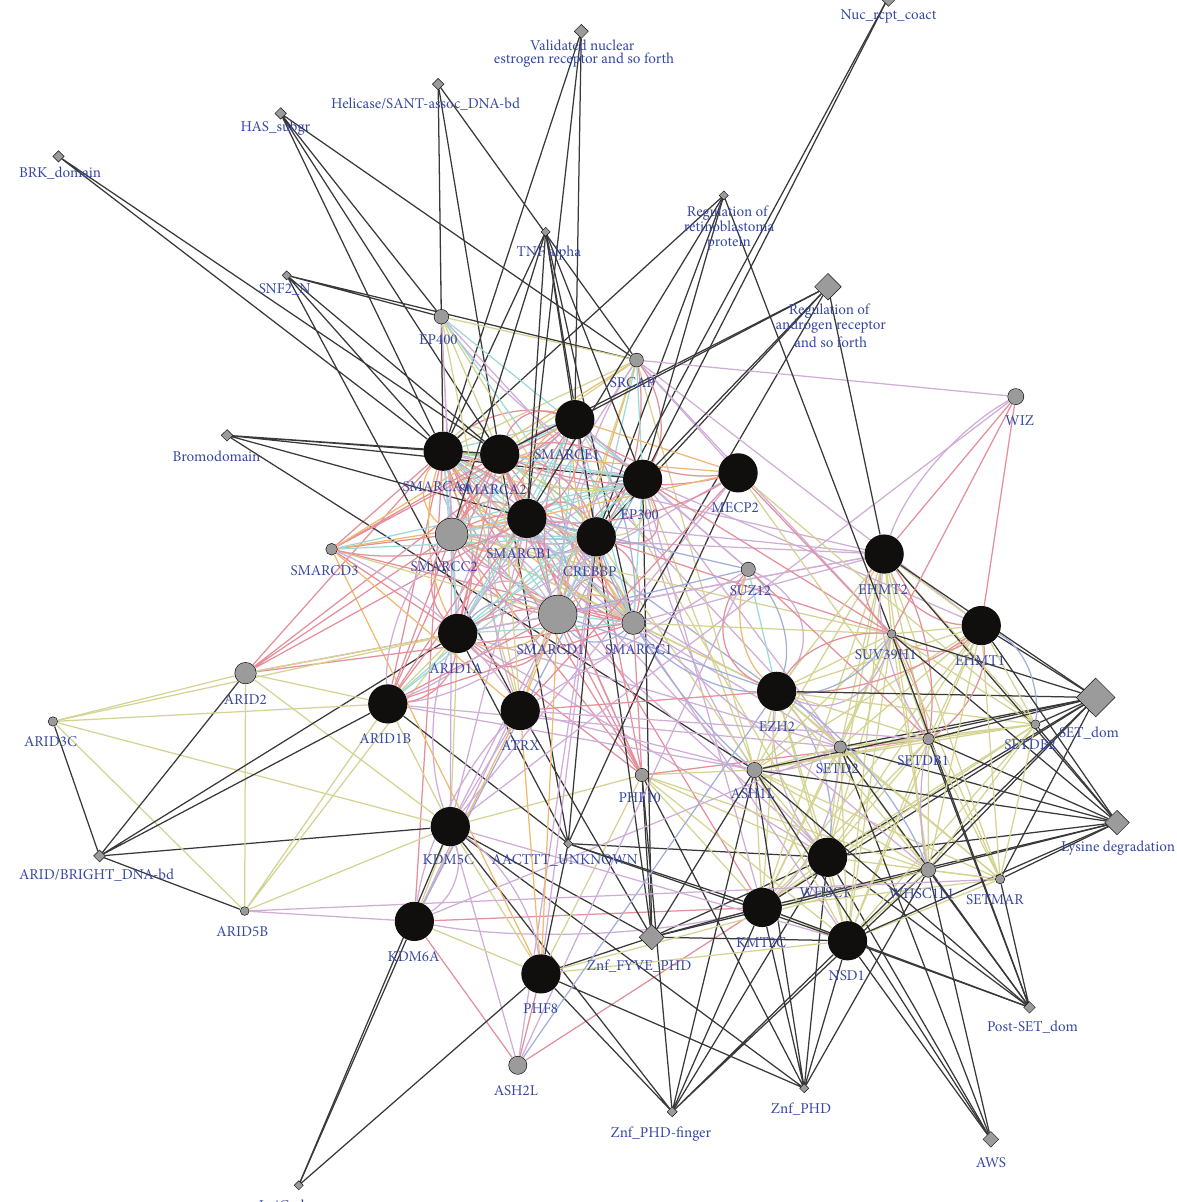
Figure 2: Protein-protein interactions of key epigenetic genes involved in genetic IDDs. Network of interactions of genes involved in the genetic IDDs arising from mutations in the epigenetic machinery (black nodes). Nodes sizes are related to the degree of the nodes (connectivity). Edge colours indicate coexpression (violet), colocalization (blue), genetic interactions (green), pathway (cyan), physical interaction (pink), predicted (orange), and shared protein domain